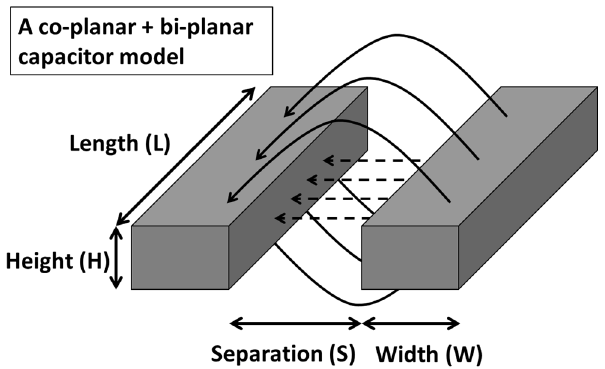
Figure 3. Schematic showing the electric field lines connecting two electrodes of the IDE capacitor. Due to the non-negligible thickness of the electrode, the two contributions of the electric field lines are the direct field lines, and the fringing field lines connected in parallel.